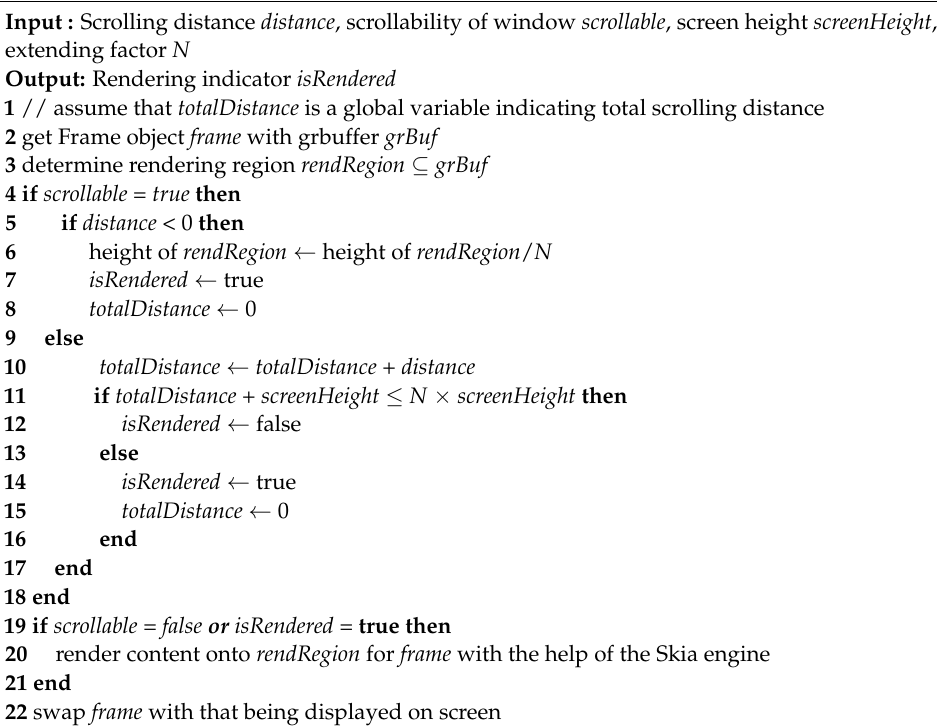
Algorithm 1. Algorithm of deciding whether to render or reuse an